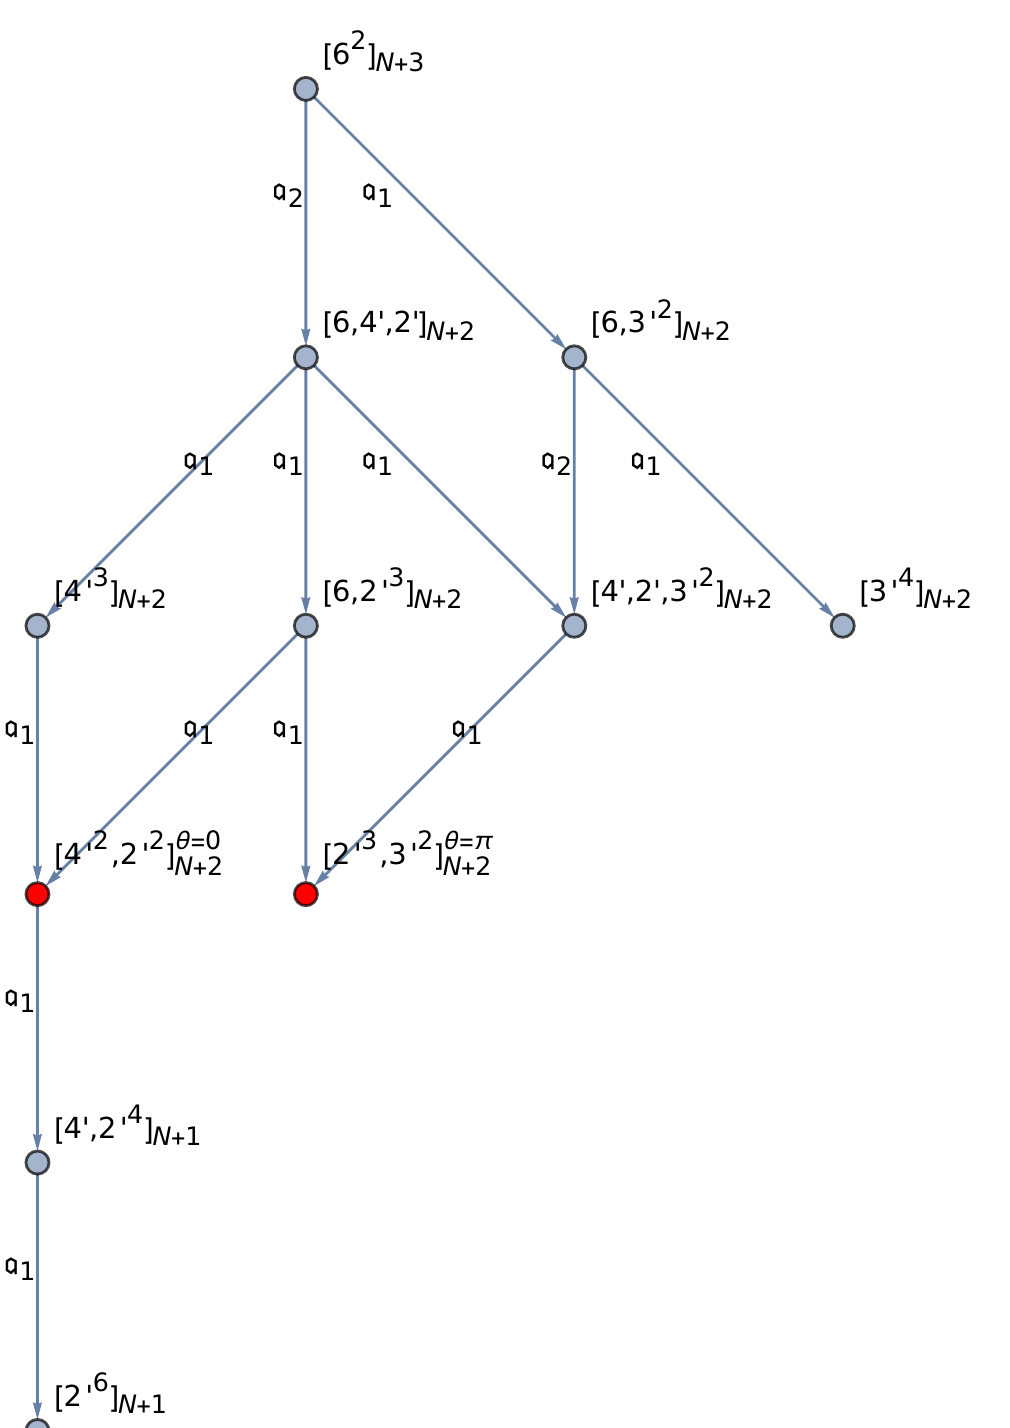
Figure 10. Hierarchy for massive E 3 -theories with n 0 = 6 and k = 18